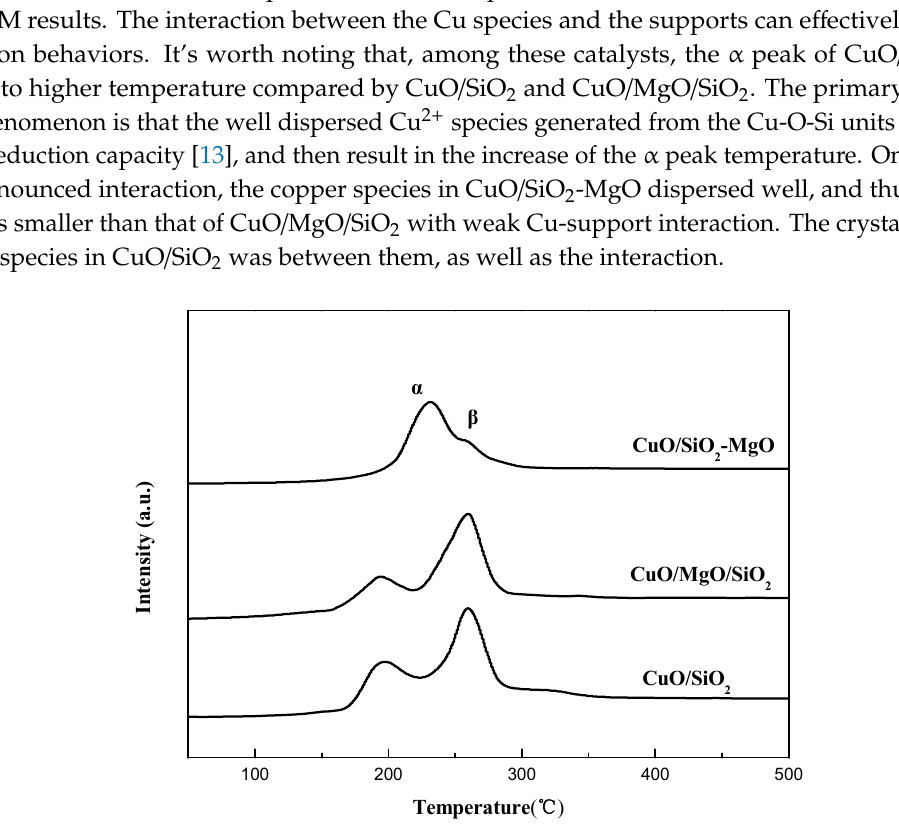
Figure 11. Cu 2p XPS spectra of the catalysts.